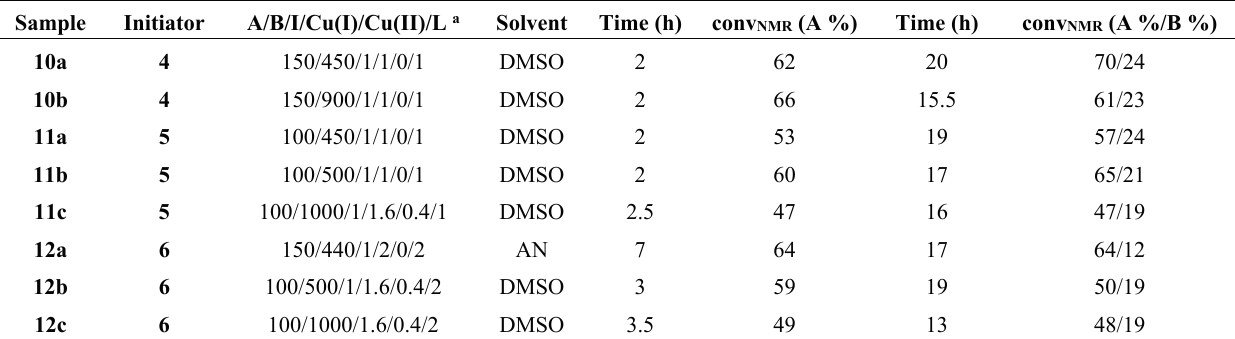
Table 2. Experimental results for the synthesis of star-like PNIPAAm- b -P(NIPAAm- co - DMAAm) block